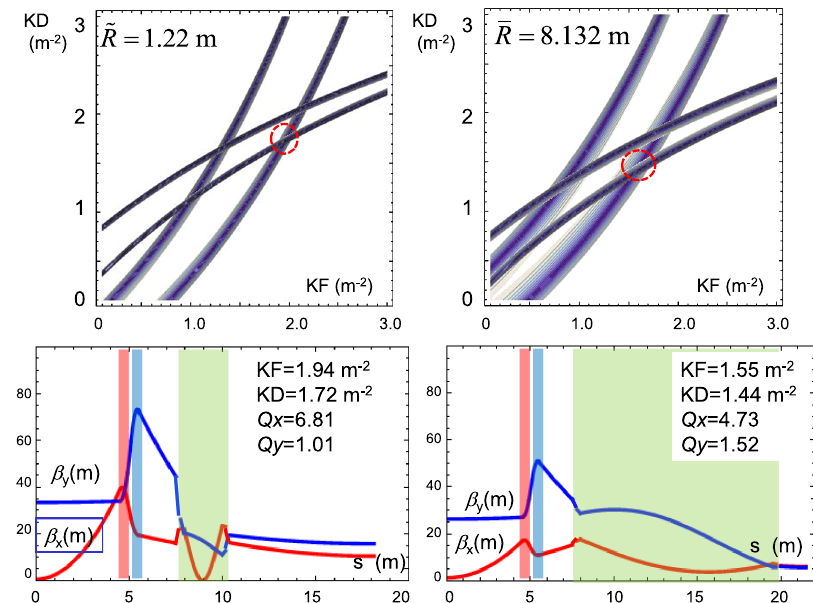
~ R ¼ 1 . 22 m ( B ρ ¼ 1 . 5 Tm